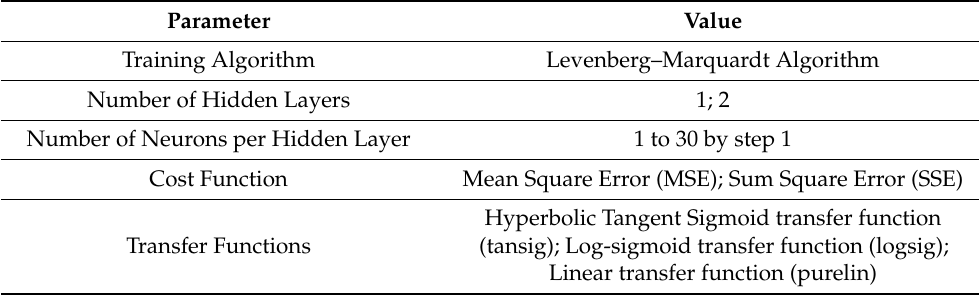
Table 2. Training Parameters of BPNN